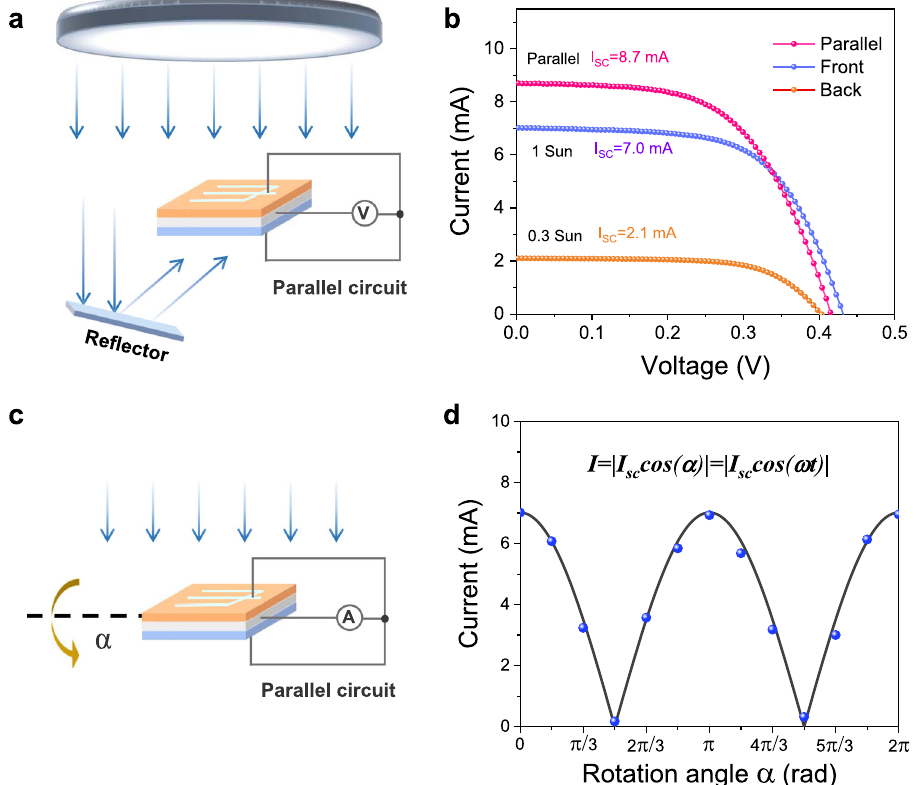
Fig. 6 Parallel output properties of bifacial fl exible CZTSSe solar cells. a Schematic diagram of performance measurement for double sides in parallel. b The I – V curves of double-sided solar cells and parallel device. c Measurement schematic diagram of parallel currents at rotation angles. d Output parallel current evolution with rotation